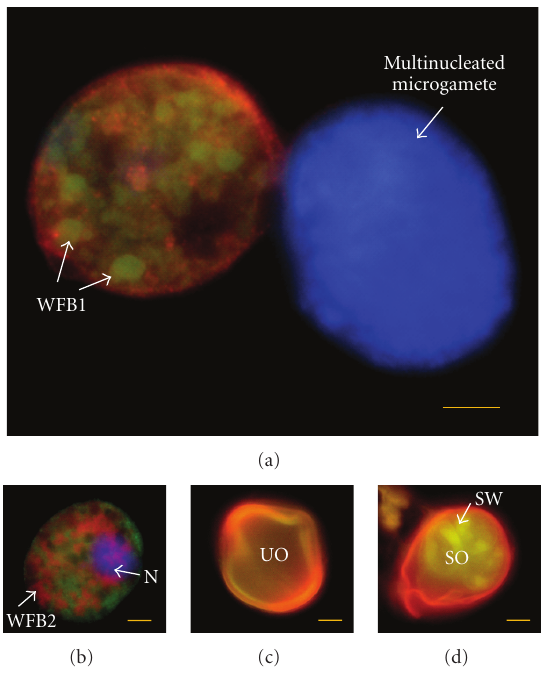
Figure 1: Developing and mature micro- and macrogametes and oocysts harvested from the infected chicken intestine 134 h post infection (p.i.) and double-labelled with a monoclonal antibody raised to antigens confound to WFB1s (E1D8) [107], and a poly- clonal a ffi nity purified gametocyte antigens Emgam56, Emgam82, and Emgam230, amongst other molecules (anti-APGA) specific to molecules contained within the wall-forming bodies (1 and 2) [53] and visualised with fluorescein isothiocyanate (green) or revealed with rhodamine-conjugated goat anti-mouse IgG secondary anti- body (red). Counterstained with DAPI. Abbreviations: N, nucleus; SO, sporulated oocysts; SW, sporocyst wall; US, unsporulated oocyst; WFB1, wall-forming body type 1; WFB2, wall-forming body type 2. Bars represent 5 μ